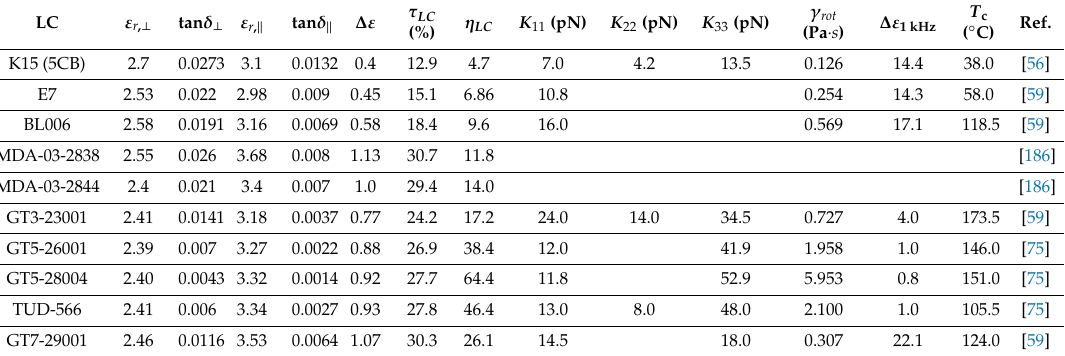
Table 1. Dielectric and elastic properties of di ff erent LC mixtures at room temperature. The values for K 11 , K 22 , and K 33 are constants for splay, twist, and bend deformations according to [191,192,195], γ rot is the rotational viscosity, ∆ ε r ,1kHz the anisotropy at low frequency, typically at 1 kHz, and τ LC and η LC are the material’s tunability and figure-of-merit, respectively. Microwave parameters are measured at 19 GHz, except for MDA-03-2838 and MDA-03-2844, which are characterized at 9 GHz.